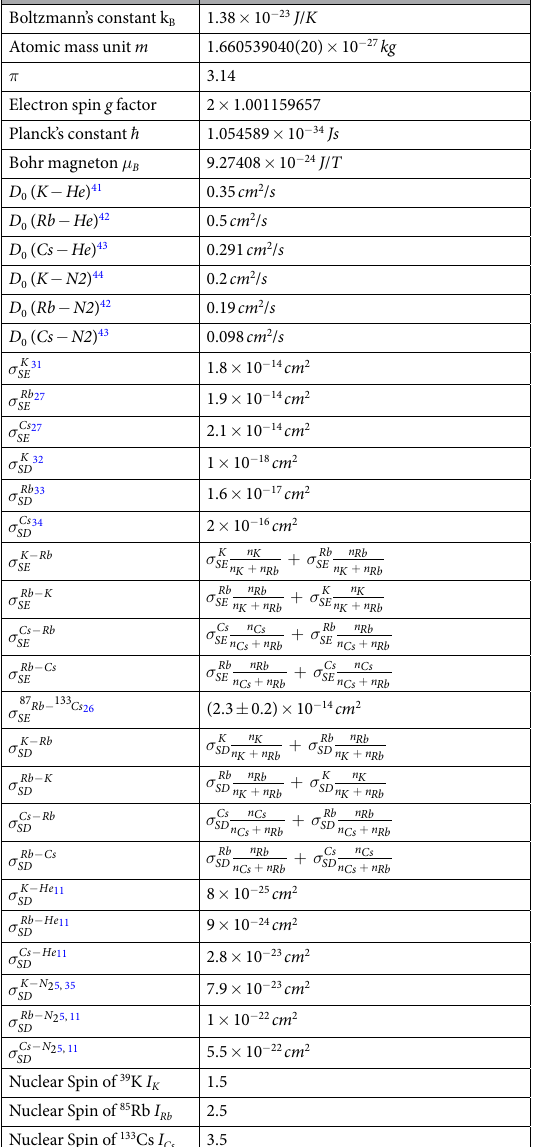
Table 1. Parameters used for the